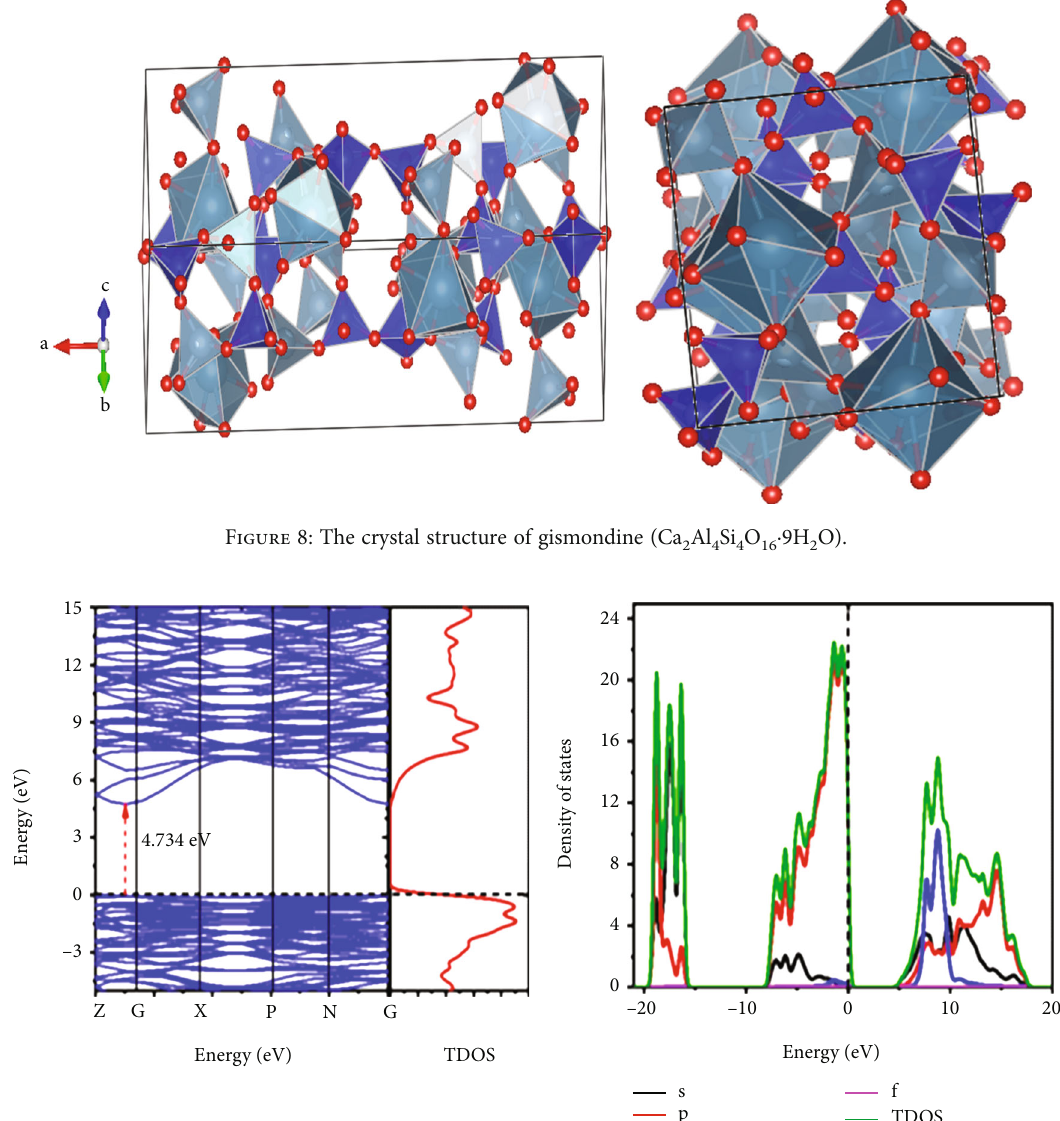
Figure 9: Band structures. (a) Electronic band structure and TDOS. (b) Projection density of states (PDOS) plot of gismondine · 9H (Ca Al Si O 2 4 4 16 2